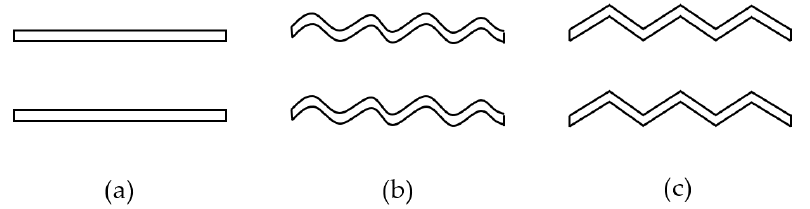
Figure 15. Three different structures: ( a ) Flat fin, ( b ) Sinusoidal corrugated fin, ( c ) Triangular corrugated fin. The thickness of the fins was set to 2 mm, the number of fins was 28, the inlet tem ‐ perature was 25 °C, and the flow rate was 16 L ∙ min − 1 . Except for the structural form of the fins, other boundary conditions were the same. The geometric models of the three fin structures are simulated respectively, and the maximum junction temperatures of the three structures are shown in Figure 16.